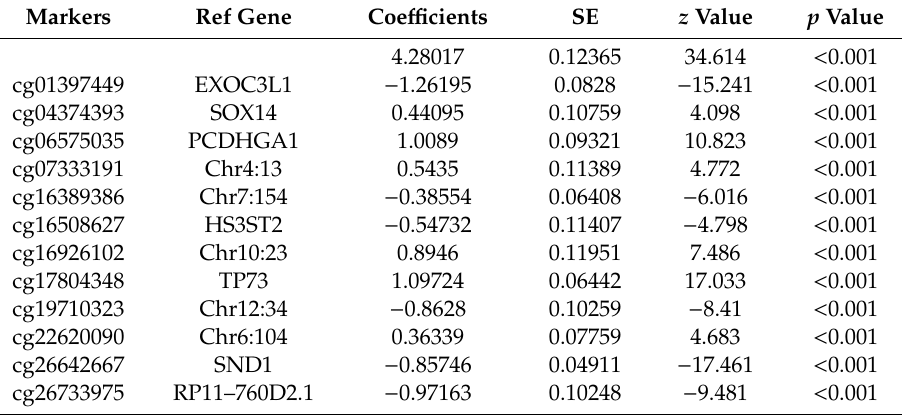
Table 1. Characteristics of 12 CpG markers in the Training data set.